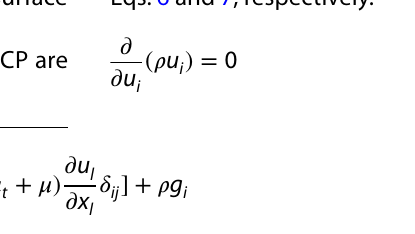
Continuity and momentum equations dedicated in Eqs. 6 and 7, respectively.